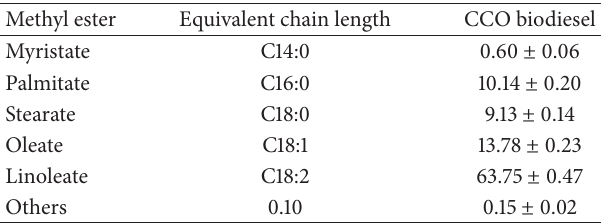
Table 4: Methyl esters composition (wt.%) of CCO biodiesel.